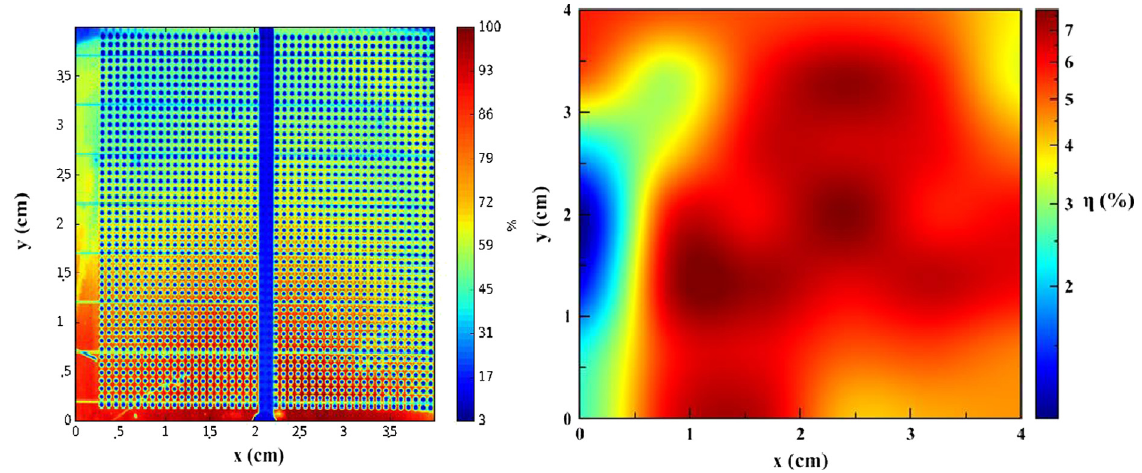
Fig. 8. (a) LBIC measurements; (b) mapping of localized ef fi ciencies.